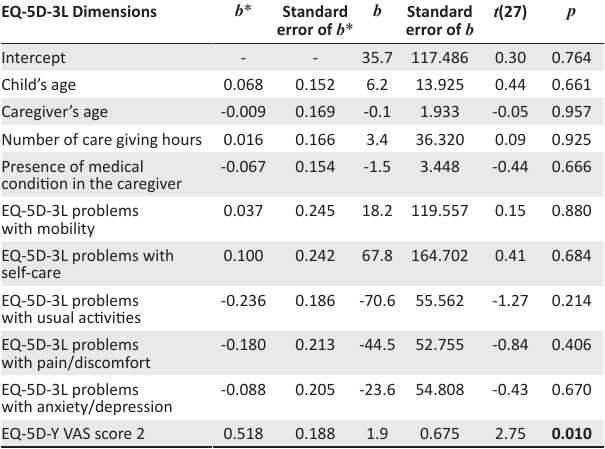
TABLE 4: Regression analysis of the caregiver’s EQ-5D-3L visual analogue scale score on day 2. EQ-5D-3L Dimensions